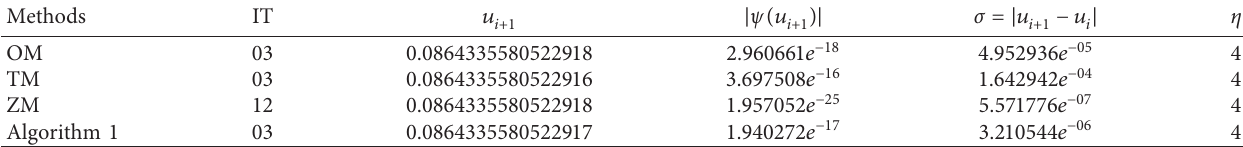
Table 2: Comparison among different fourth-order algorithms.